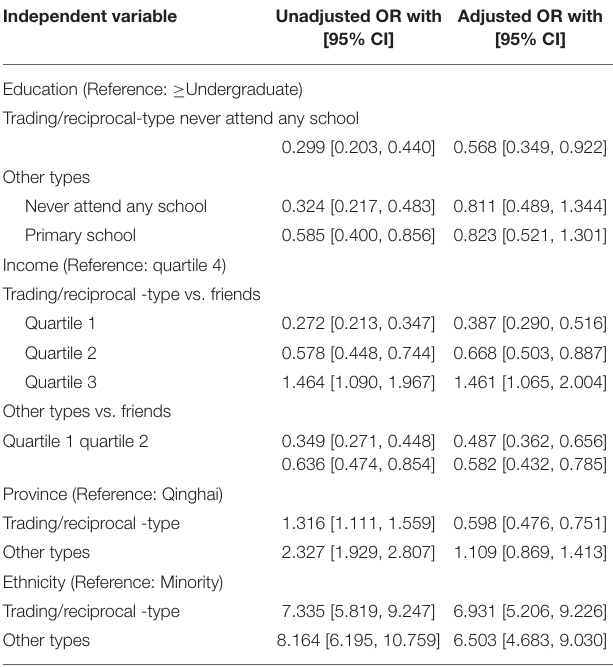
TABLE 5 | Multinomial regression models for relationship with grass-roots doctors. Independent variable